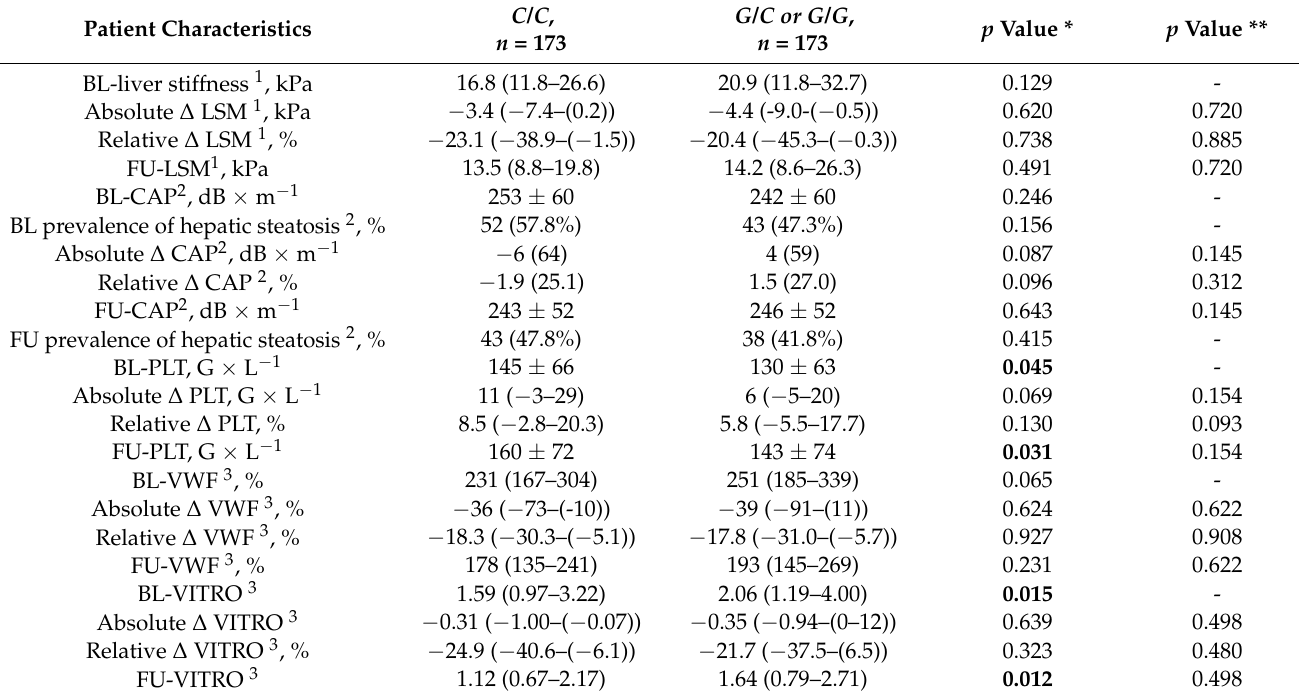
Table 2. Comparison of dynamics in LSM, VWF, PLT, and VITRO score between patients of cohort B with the PNPLA3 rs738409 G-allele, or without. Abbreviations: BL baseline, FU follow-up, LSM liver stiffness measurement, PLT platelet count, VWF von Willebrand factor, VITRO von Willebrand factor antigen/platelet count ratio. Patient